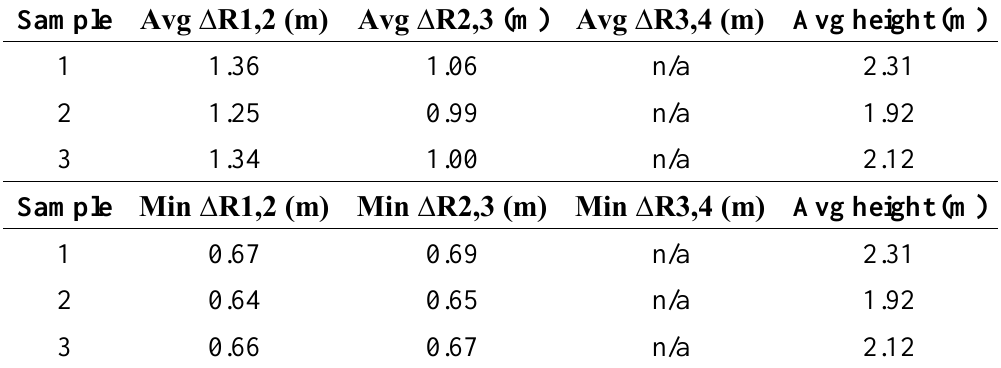
Table 1. ALTM-Orion: Average and minimal multiple return separation distances for the cornfield data; the last column shows the average vegetation height in the selected samples.